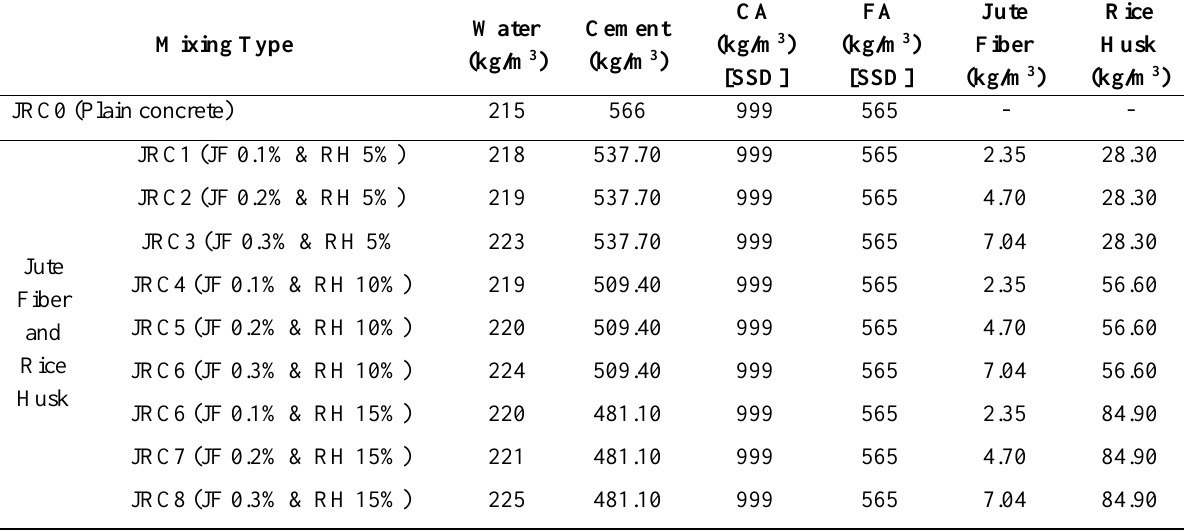
Proportion of concrete mix used for experimental